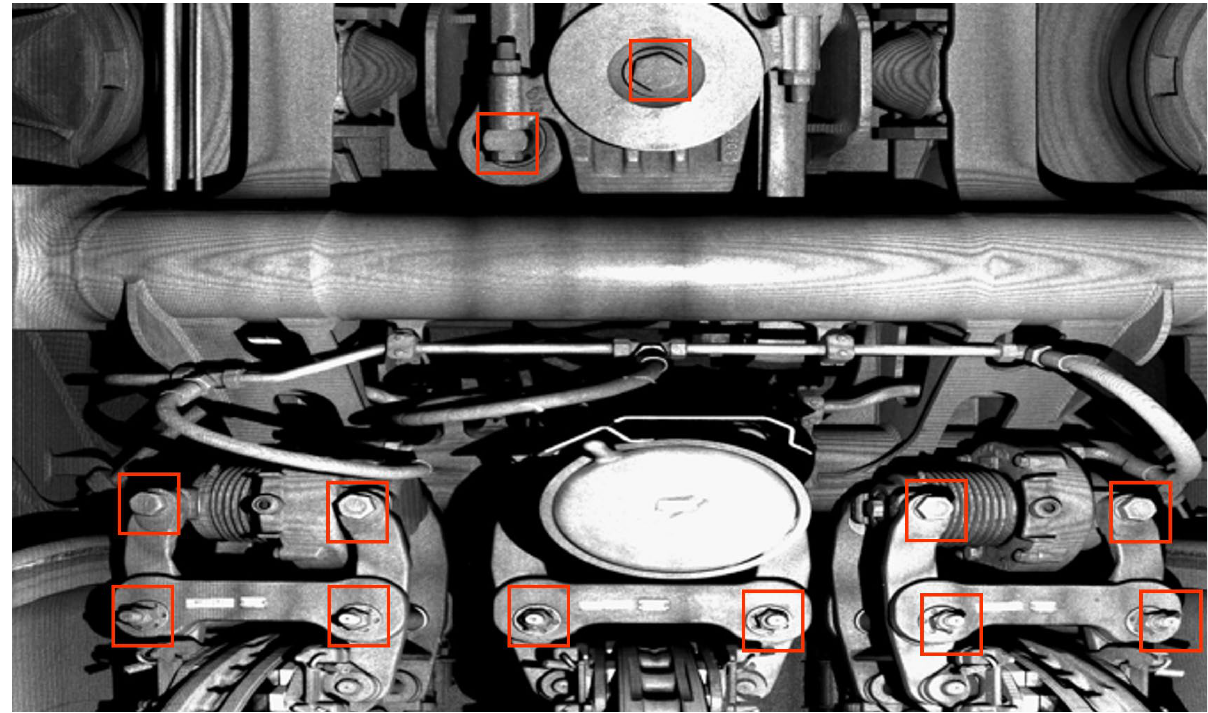
Figure 1. Scenes from an underneath high-speed train. The red square marks the bolts.